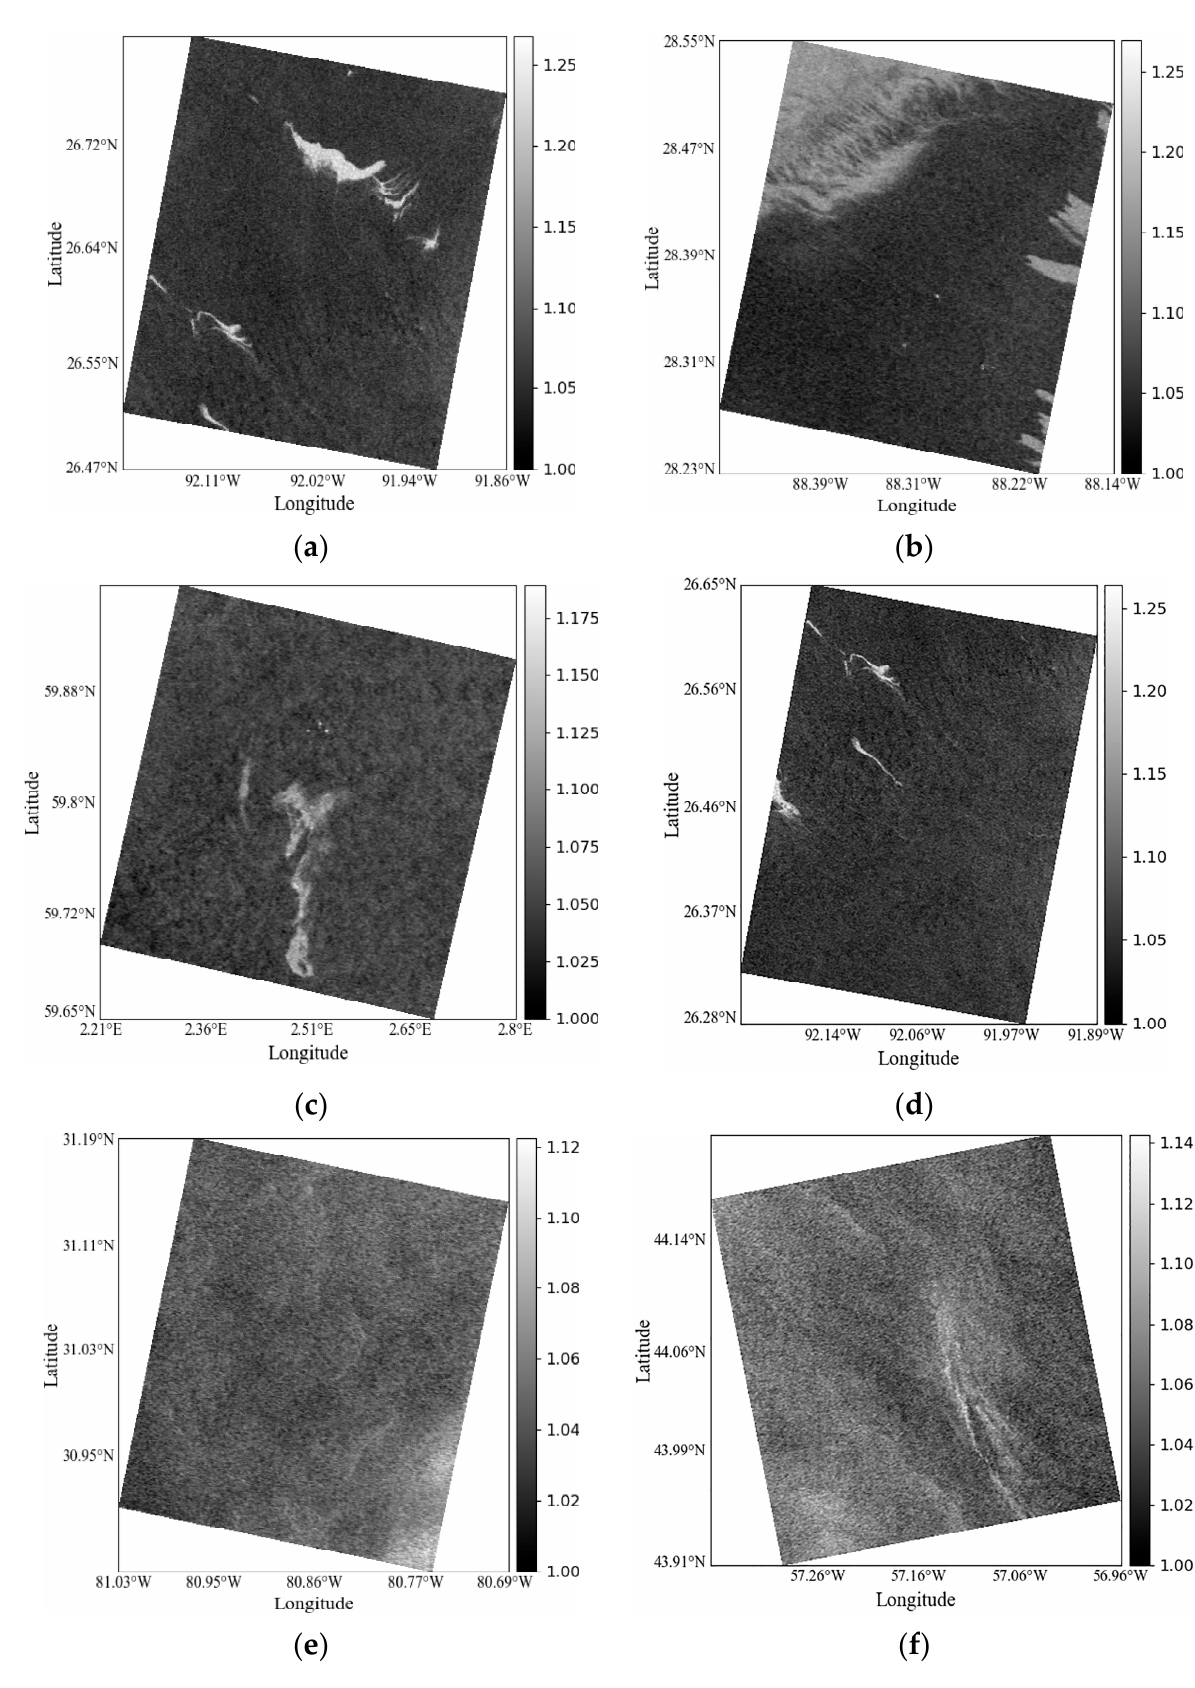
Figure 6. Feature images of 𝑃𝑅 . ( a – f ) are Cases 1–6, respectively.